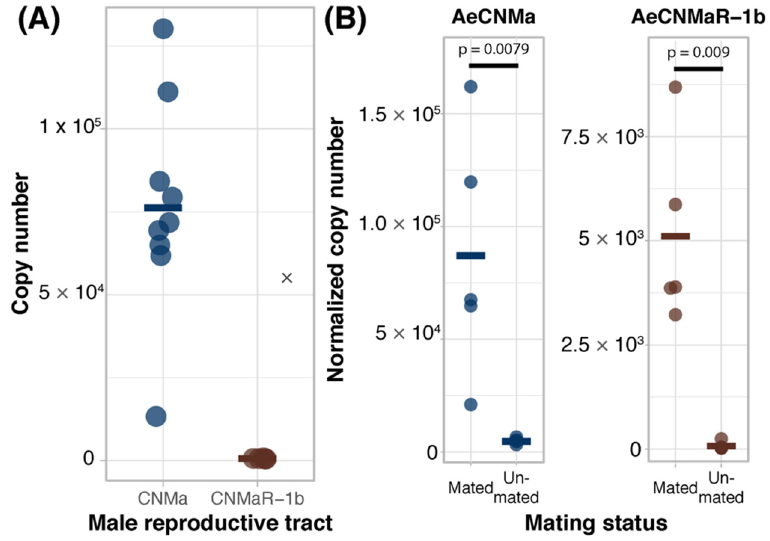
Figure 4. Ligand and receptor expression in male reproductive tissues and induction of AeCNMa and AeCNMaR-1b in females by mating. ( A ) AeCNMa was expressed at high levels in male reproductive tracts (testes and accessory glands), while expression of the receptor AeCNMaR-1b was negligible. ( B ) Mating of virgin females induced expression of AeCNMa ( p = 0.0079, Wilcoxon signed-rank test) and AeCNMaR-1b ( p = 0.009, Wilcoxon signed-rank test).